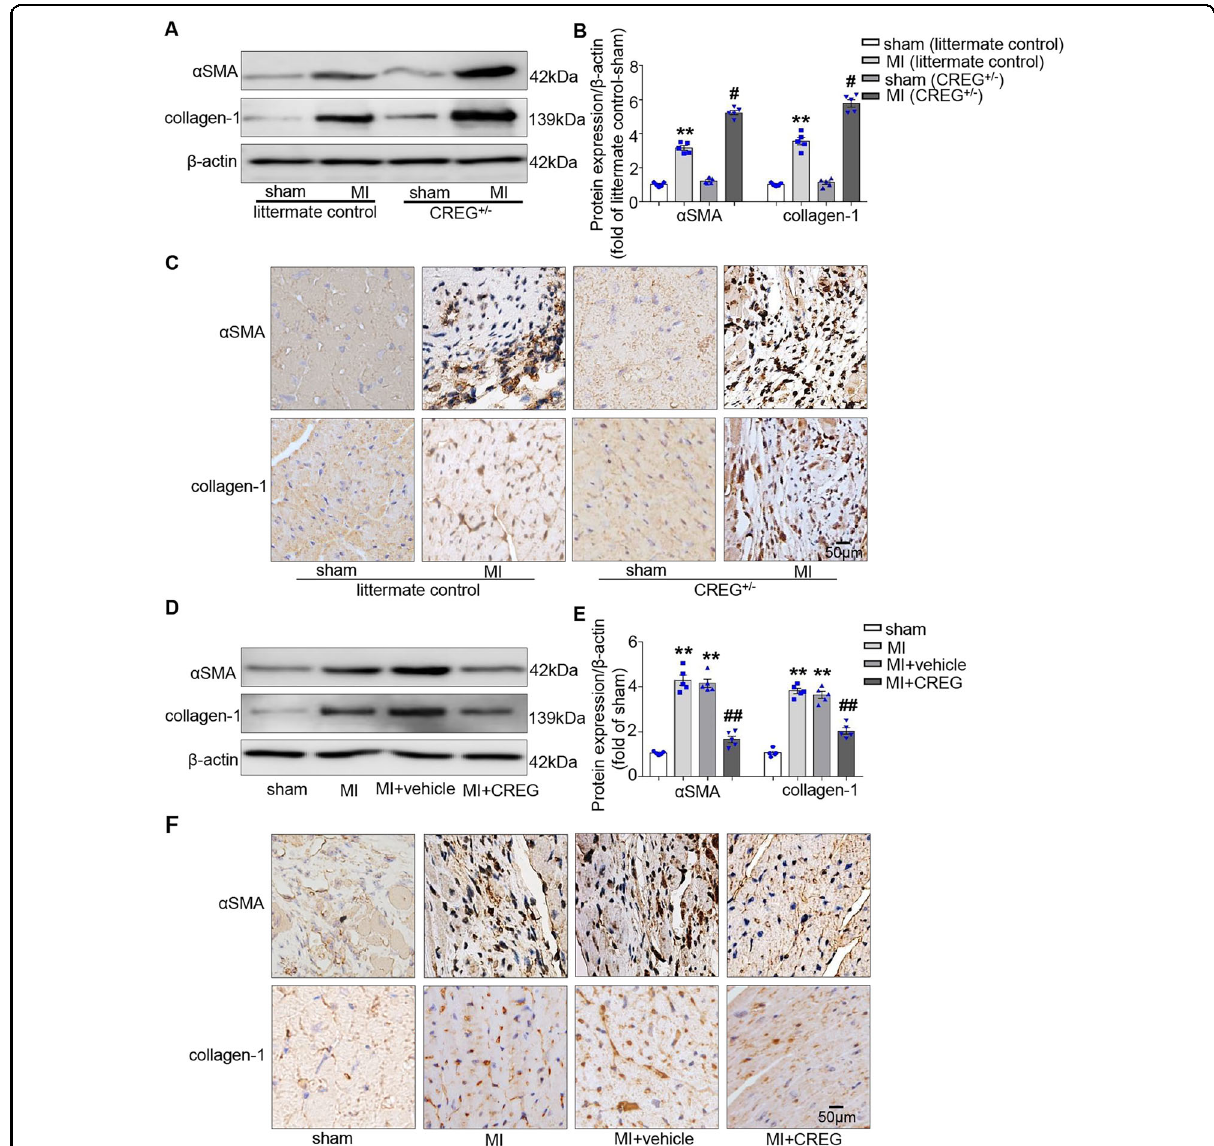
Fig. 4 CREG recombinant protein inhibited cardiac myo fi broblast activation in the border zone of the myocardium after MI. A , B Western blotting analysis of α SMA and collagen-1 expression in the border zone of the myocardium in CREG heterozygous mice (CREG + / − ) on post-MI day 14 ( N = 5 per group). C Immunohistochemical analysis of α SMA and collagen-1 expression in the border zone of the myocardium in CREG + / − mice on post-MI day 14 ( N = 3 per group). D , E Western blotting of α SMA and collagen-1 expression in the border zone of the myocardium in C57BL/6J mice with exogenous CREG recombinant protein (rCREG) on post-MI day 14 ( N = 5 per group). F Immunohistochemical analysis of α SMA and collagen-1 expression in the border zone of the myocardium in C57BL/6J mice with rCREG on post-MI day 14 ( N = 3 per group). ** P < 0.01 vs. sham group; # P < 0.05 vs. littermate control-MI, ## P < 0.01 vs. MI + vehicle